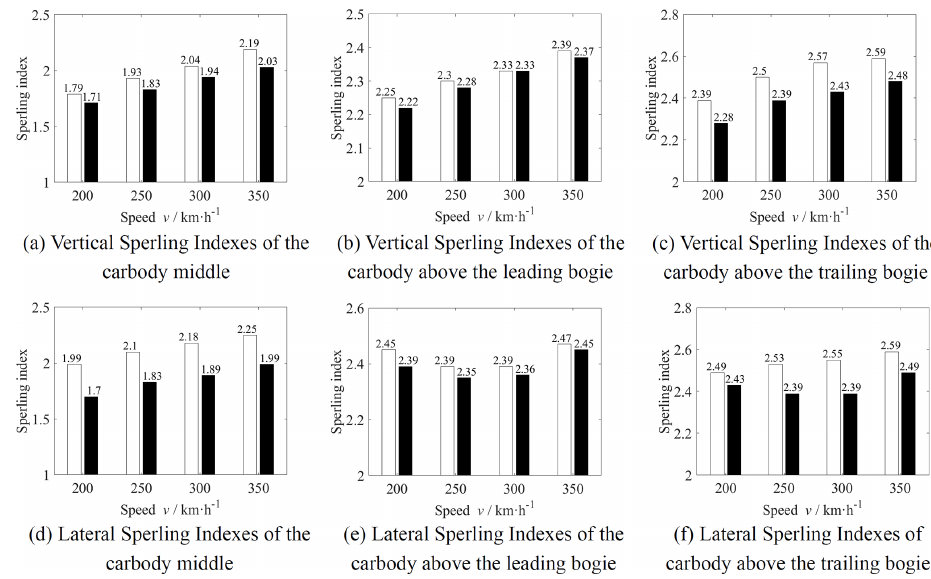
Figure 10. Sperling indexes of different connection methods (white column – with MDOF DVA; black column – without DVA).